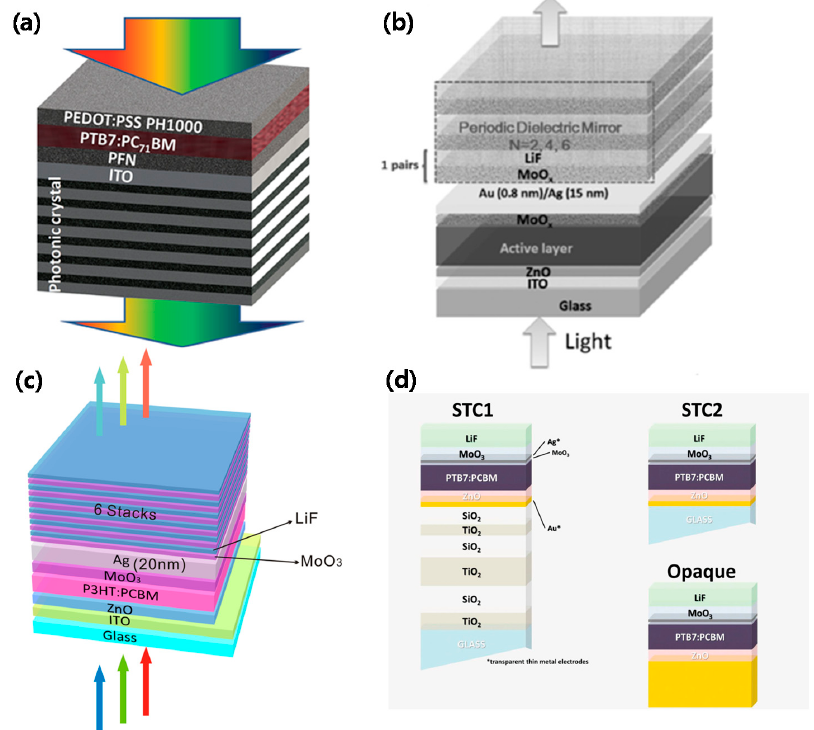
Figure 6. Device engineering of STOSCs for improving light harvesting: ( a ) Schematic of a STOSC with one-dimensional photonic crystal. Reprinted with permission from [55]. Copyright 2016 Royal Society of Chemistry. Schematic of STOSCs with ( b ) MoO x /LiF and ( c ) MoO 3 /LiF. Reprinted with permission from [56,57]. Copyright 2017 Wiley; Copyright 2013 ACS. ( d ) Schematic illustration of the semitransparent device cell architecture incorporating the multilayer dielectric structure (MLD)